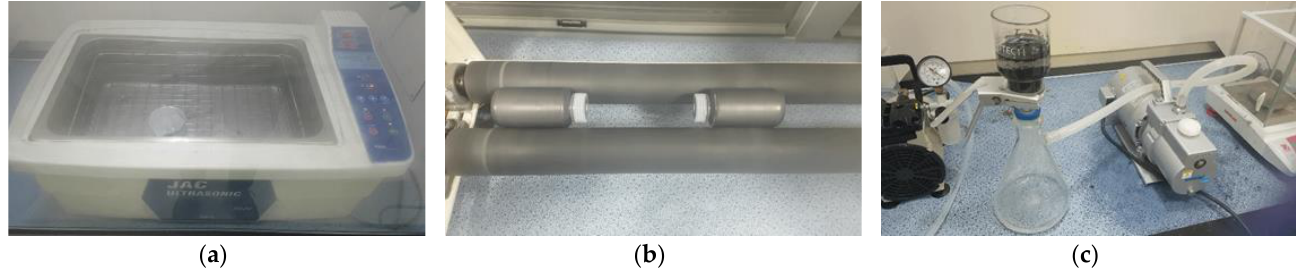
Figure 1. Noncovalent functionalization of MWCNTs and GNPs: ( a ) ultrasonication of MWCNTs or GNPs with melamine in DMF, ( b ) ball milling, and ( c ) washing.